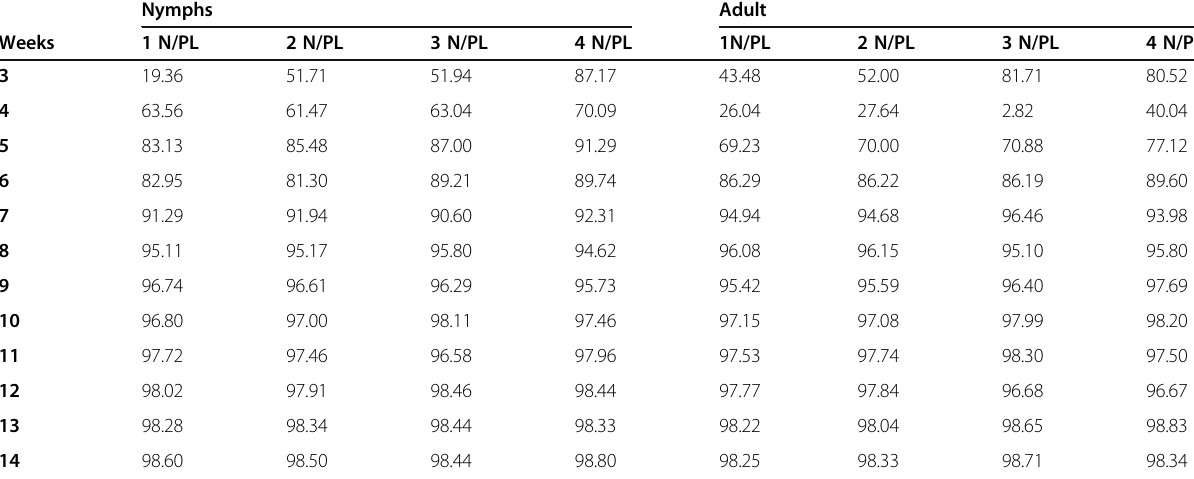
Table 1 Efficacy rate of Nesidiocoris tenuis against Bemisia tabaci nymphs and adults as a function of treatment and time Nymphs Adult